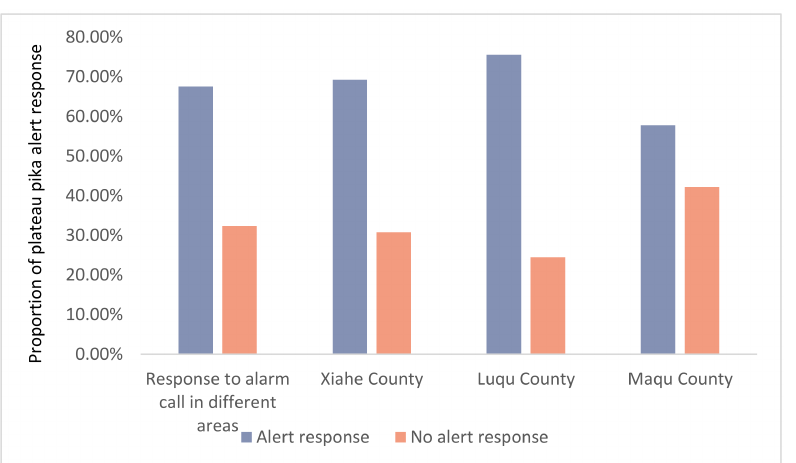
Figure 7. In these three areas, through analyzing the behavioral responses after playback of the alarm call ( p > 0.05), it was found that there was no significant difference in the response of vigilance behavior.